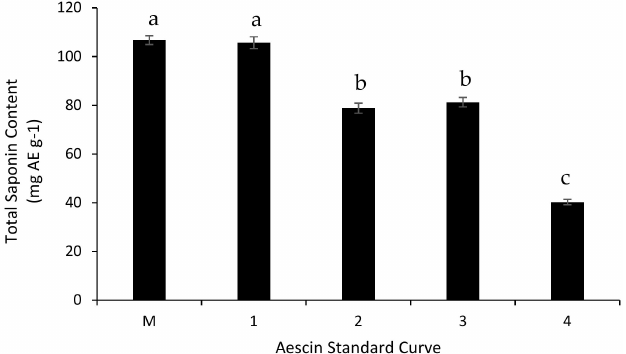
Figure 4. The total saponin content (TSC) of the Gac ( Momordica cochinchinensis Spreng) seed kernel powder determined using ethanol as the extraction solvent and the modified method with the aescin standard curve in Figure 3 (M) and the unmodified method with the four aescin standard curves in Figure 2 (1–4). The values are the means of three replicates for each extraction. Columns not sharing the same superscript letter are significantly different at p <